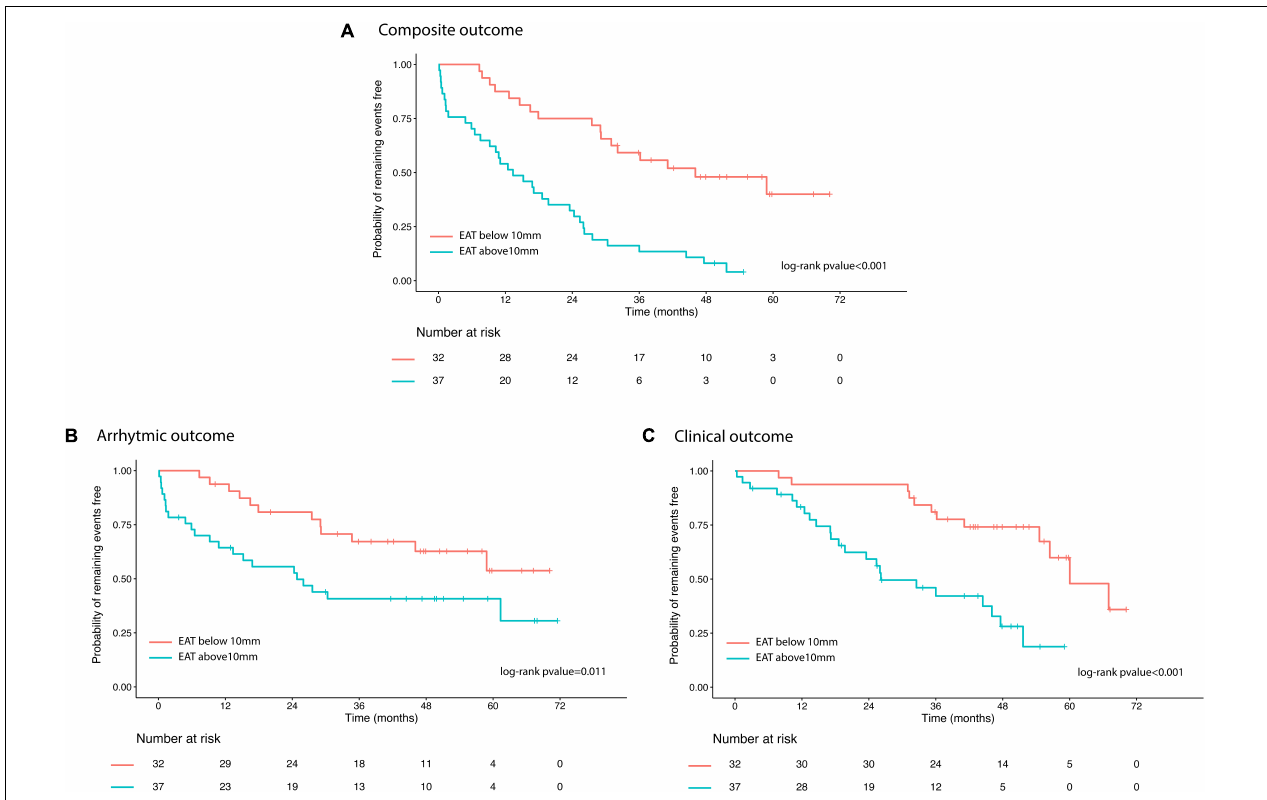
FIGURE 2 | Kaplan Meiers curves illustrating the probability of remaining events free for each of the three considered outcomes [panel (A) composite outcome; panel (B) arrhythmic outcome; panel (C) clinical outcome] and stratified according to EAT median value. EAT, epicardial adipose tissue.